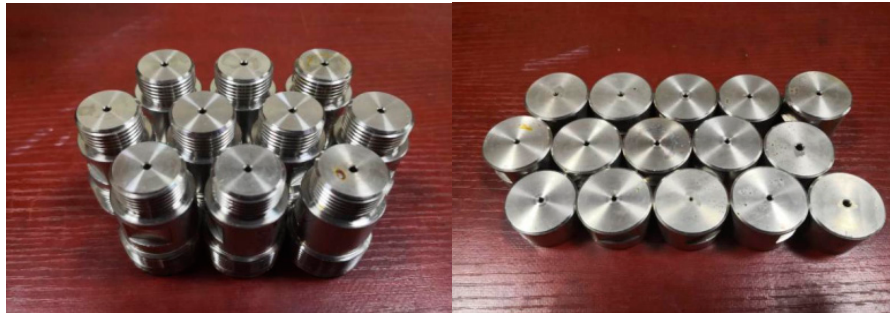
Figure 4. The physical diagram of OH self-excited oscillation nozzle.